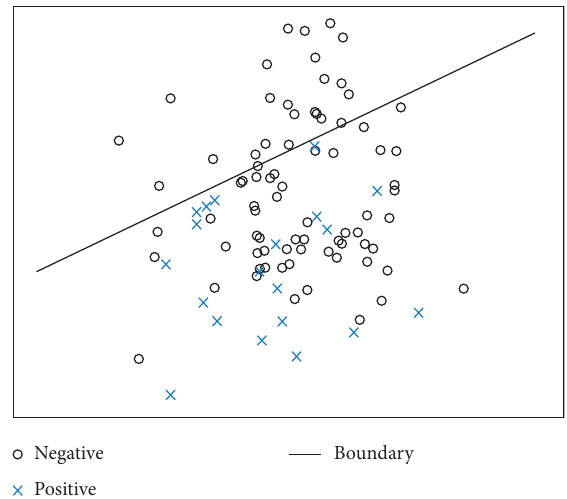
Figure 1: Limitations of the data distributions of various